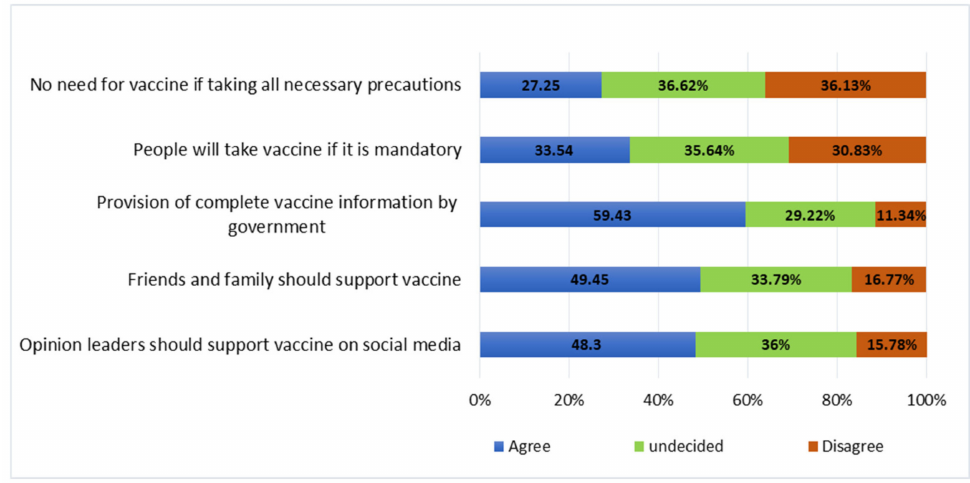
Figure 5. Cues for action to work on improving the COVID-19 vaccine uptake among health